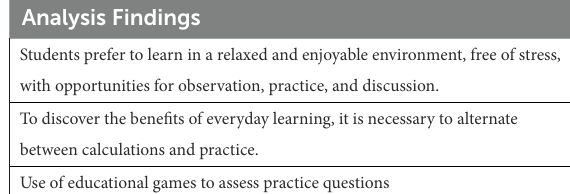
TABLE 5 Analysis of student learning